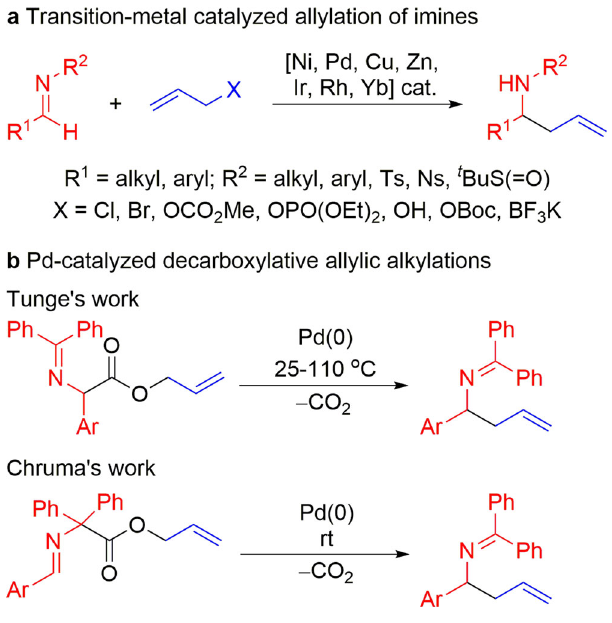
Fig. 1 General strategies for homoallylic amine synthesis. a Transition- metal-catalyzed allylation of imines. b Pd-catalyzed decarboxylative allylic alkylations.